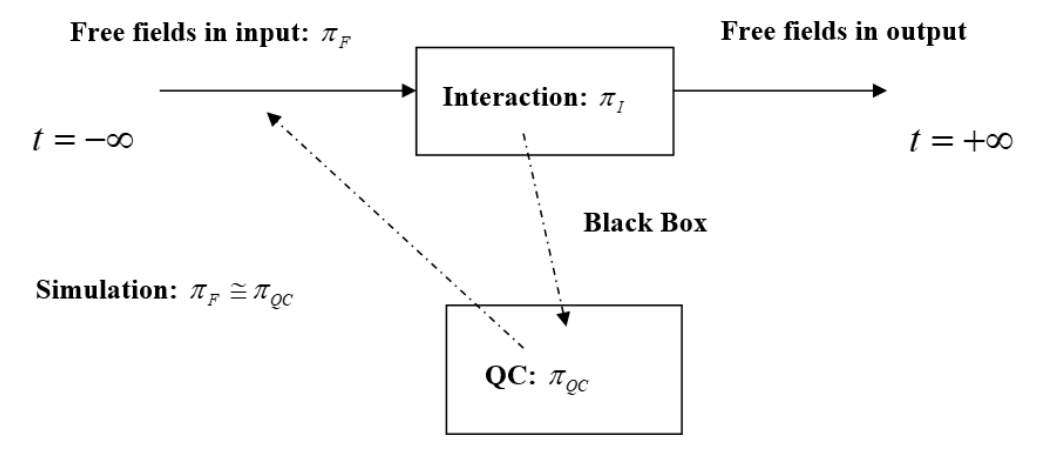
Figure 8. The black